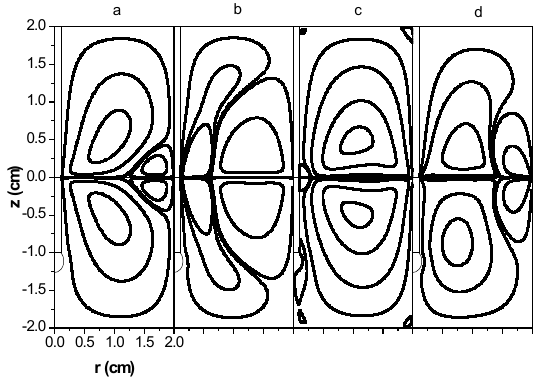
Figure 4: Streamlined distribution during the termination of the Marangoni instability at liquid/liquid interface (see text for details). Reprinted with permission from [7]. Copyright 2005 American Chemical